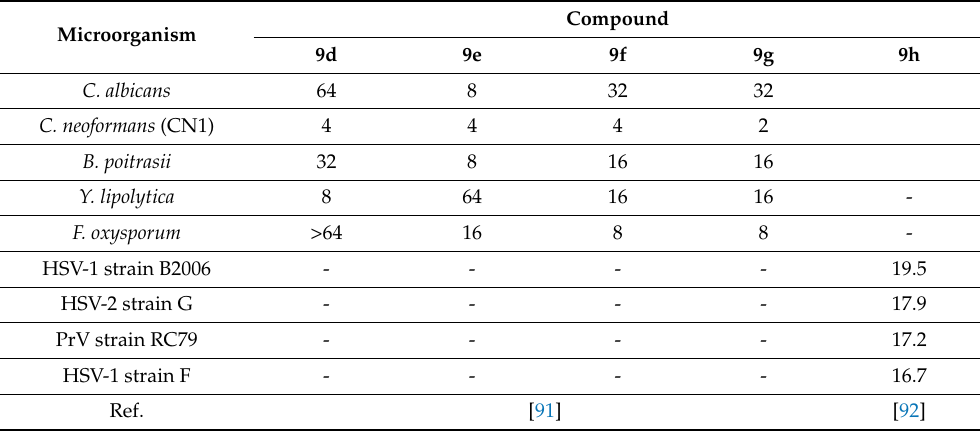
Table 11. MIC values ( µ g/mL) of cholestane oxime derivatives.